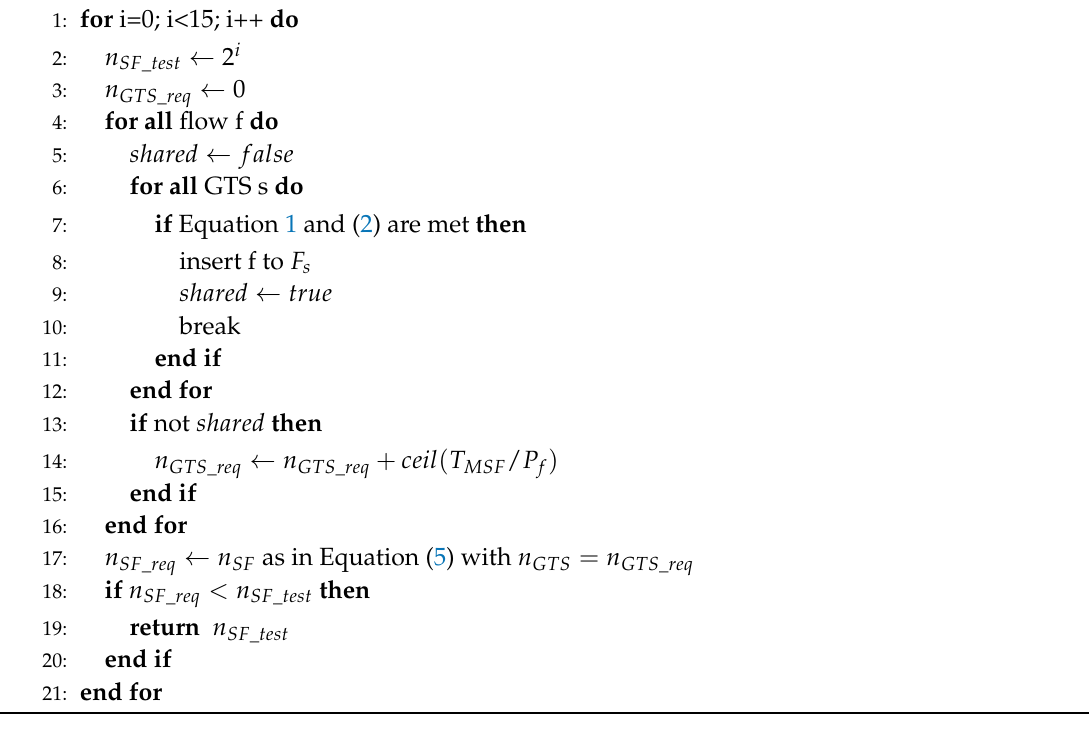
Algorithm 1: Algorithm used to assess the network